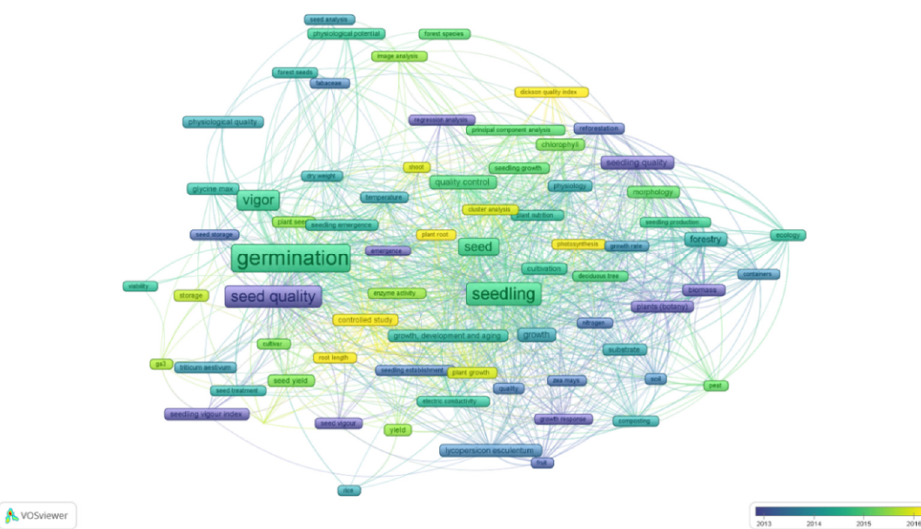
Figure 4. Overlay visualisation map. Different colors indicate the evolution of research keywords over time based on the average publication year. Following a similar procedure, an overlay visualisation map was drawn to identify the evolution of keywords used in the set of articles analysed in this study. Earlier research topics are coloured purple and more recent items are shown in yellow. The data were processed and mathematically analysed using the clustering algorithm of the VOSviewer